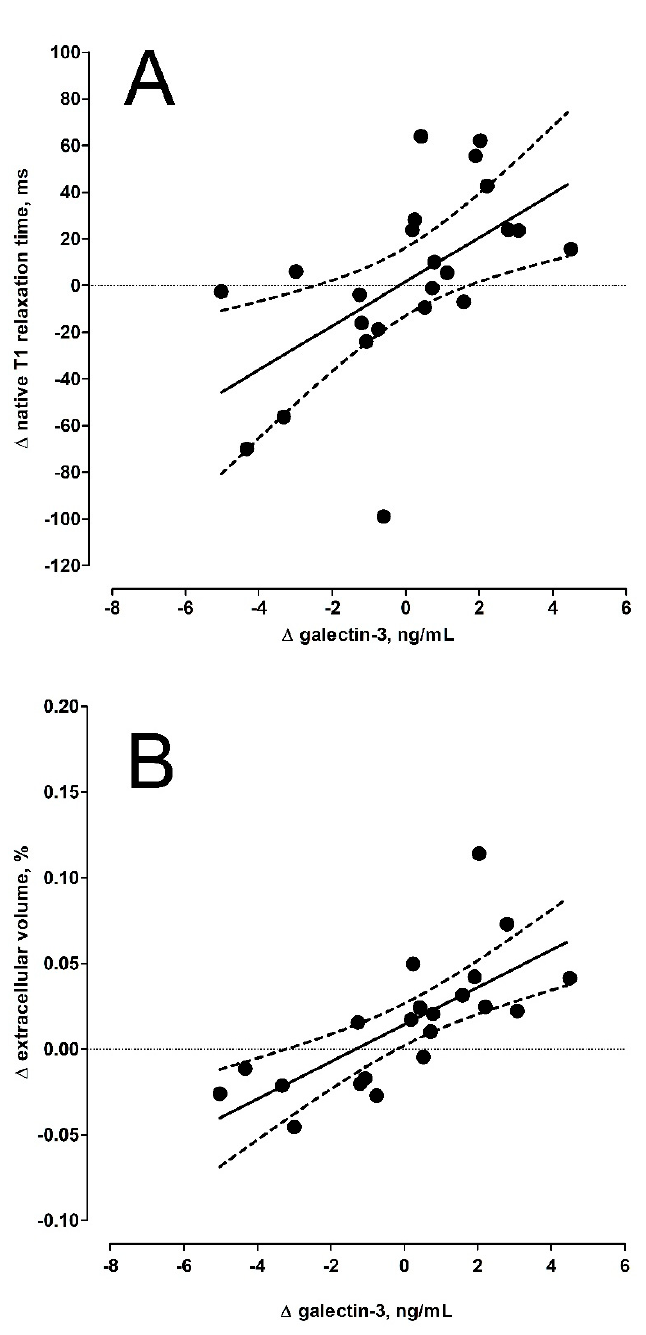
Figure 1. Relation between changes in galectin-3 levels and changes in native T1 relaxation time (panel ( A )) and changes in extracellular volume (panel ( B )).